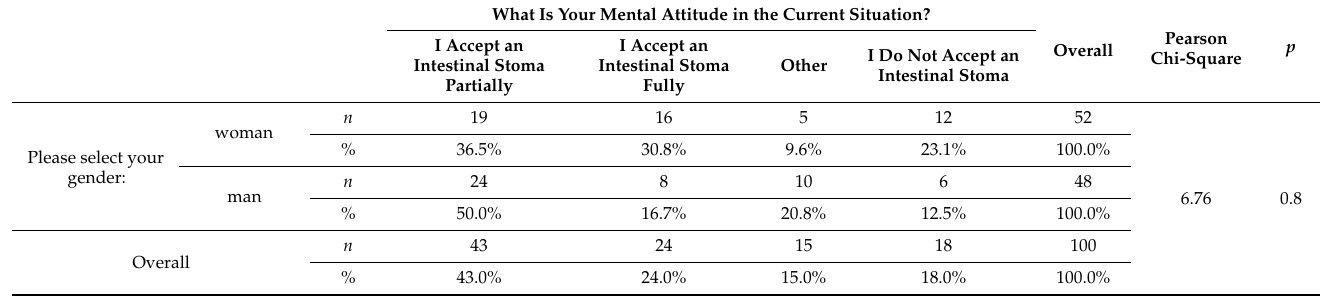
Table 6. Intestinal stoma acceptance and gender.